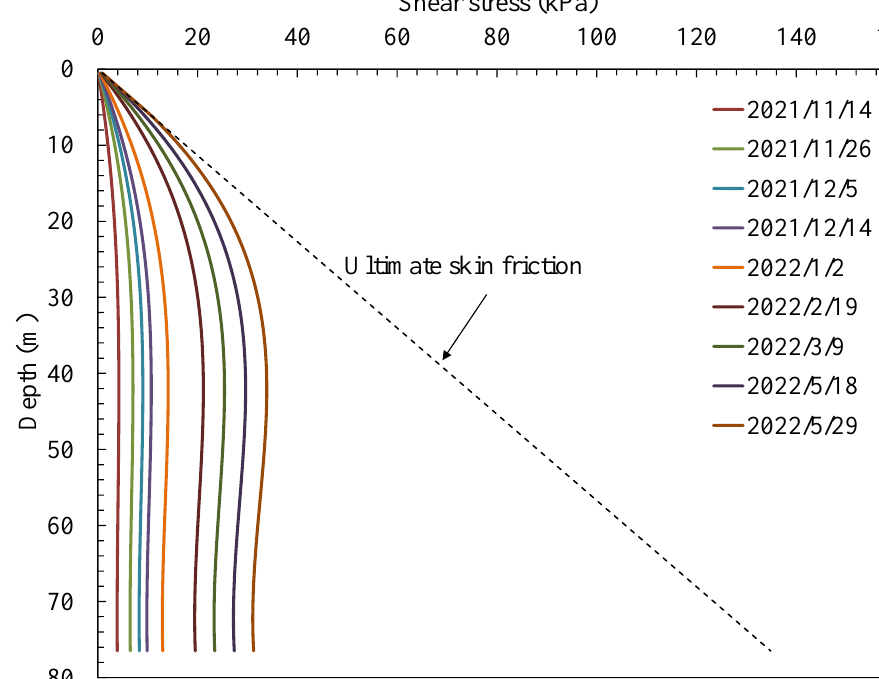
Figure 16. Development of skin friction.